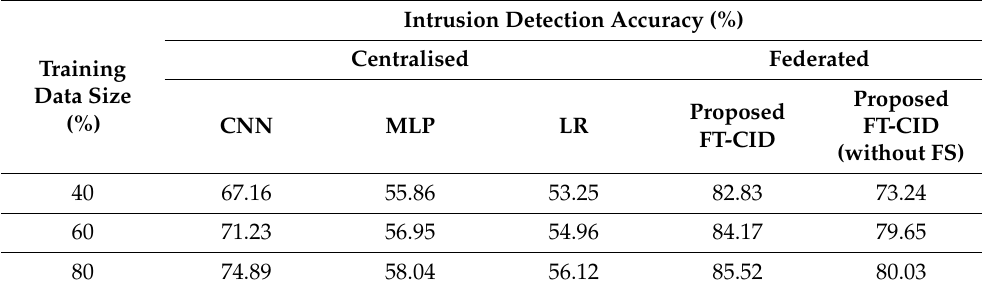
Table 4. Comparative experimental results of intrusion detection accuracy.